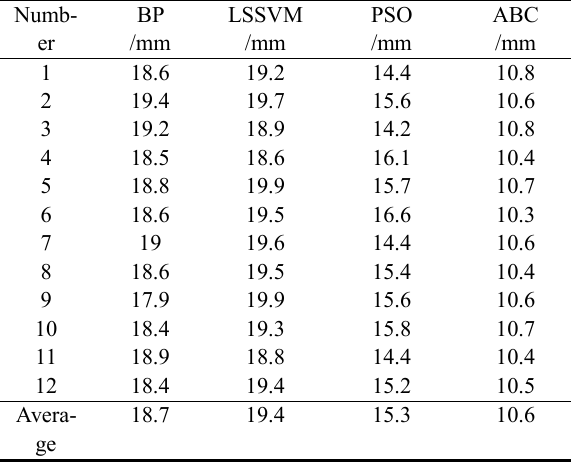
Table 3. Comparison of detection accuracy of different methods Statistical experimental data can be seen that whether it is the accuracy of each experiment or the accuracy of the 12 experiments, the artificial bee colony improved fitting method is better than the other three methods, the improved bee colony improved fitting method The average accuracy of the fitted model is ±10.6mm. On the basis of selecting the same set of test data, the overall fitting accuracy of the particle swarm optimization algorithm is increased by 30.7%. The fitting accuracy of the conventional LSSVM fitting method is